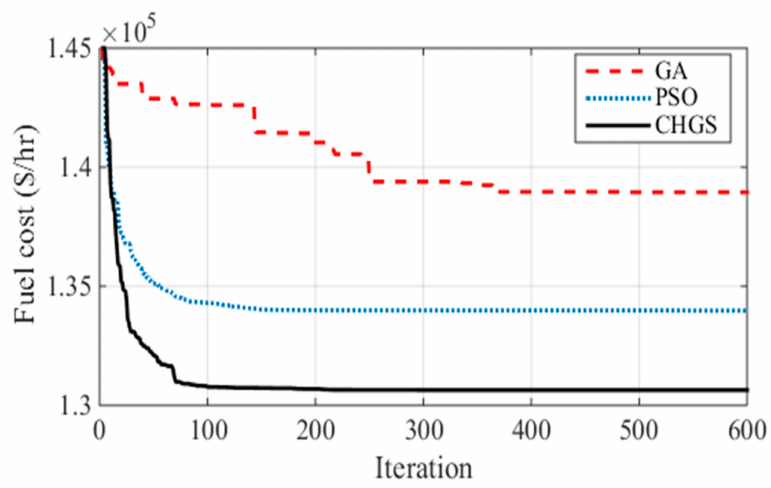
Figure 4. Simulated cost function convergence in case of the 118-bus